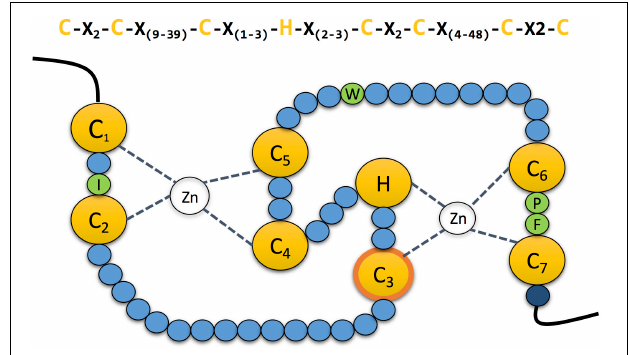
FIGURE 2 | The zinc coordinating residues in RING domains. Schematic representation of the cross-brace” topology of RING domains. The RING domain contains seven conserved cysteines and one histidine (yellow) which are involved in the coordination of two atoms of zinc. The third cysteine mediates the ubiquitin transfer in the second RING domain in RBR E3 ubiquitin ligases (contour labelled in orange). Four conserved residues (green) guide the interaction with the E2 conjugating enzyme. Mutation of the last residue of the domain (dark blue), which is normally a positively charged arginine or lysine, compromises the stability of the adjacent cysteine, affecting the coordination of the zinc